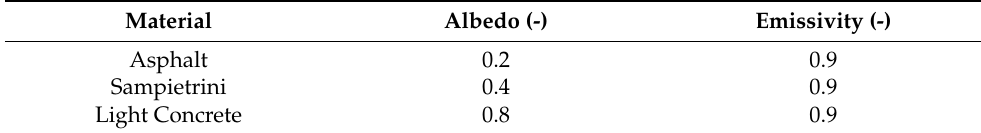
Table 1. Physical characteristics of the pavement materials.